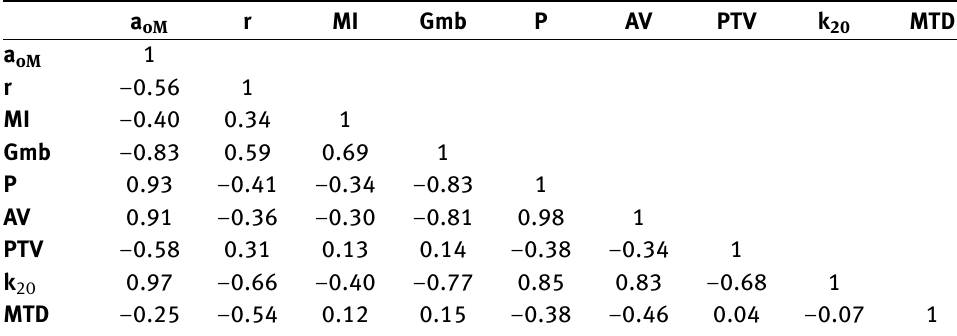
Table 7: Correlation matrix among measured parameters